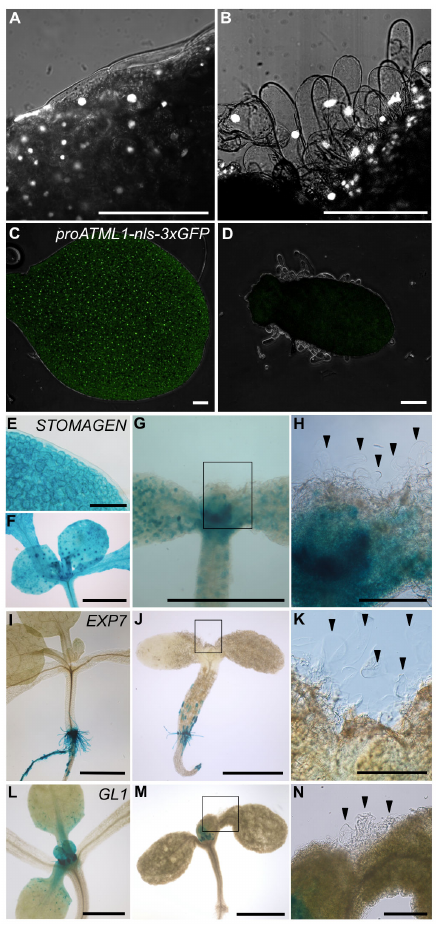
Figure 5. Marker gene analyses of the filamentous protrusions formed on the surface of ATML1-SRDX seedlings. ( A , B ) Confocal images of cotyledons from eight- day-old seedlings of the wild type (A) and ATML1-SRDX line 1 (B) grown with 10 μM estradiol. Nuclei were stained with SYBR Gold nucleic acid gel stain (white signals). ( C , D ) proATML1- nls-3xGFP expression (green nuclear signals) in cotyledons from seven-day-old seedlings of the wild type (C) and ATML1- SRDX line 1 (D) grown with 10 μM estradiol, observed under a confocal laser scanning microscope. Images were taken under the same confocal microscope settings. ( E , F ) Wild-type expression patterns of STOMAGEN-GUS (shown in blue) in a cotyledon (E) and the shoot apex (F). ( G ) STOMAGEN-GUS expression (shown in blue) in a seven-day-old seedling of the ATML1-SRDX line 1 grown with 10 μM estradiol. ( H ) Magnified view of the inset in G. ( I , J ) EXP7-GUS expression (shown in blue) in seven-day-old seedlings of the ATML1-SRDX line 3 grown with DMSO (I) and 10 μM estradiol (J). ( K ) Magnified view of the inset in J. ( L , M ) GL1-GUS expression (shown in blue) in seven-day-old seedlings of the wild type (L) and ATML1-SRDX line 3 (M) grown with 10 μM estradiol. ( N ) Magnified view of the inset in M. The arrowheads indicate filamentous protrusions. Scale bars, 100 μm for A, E; 200 μm for B–D, H, K, N; and 1 mm for F, G, I, J, L, M. doi: 10.1371/journal.pone.0079312.g005 PLOS ONE |